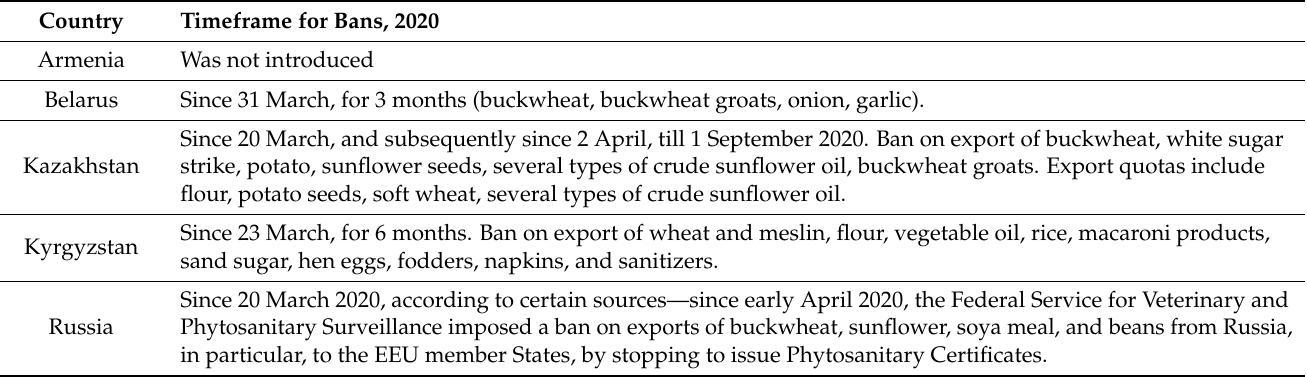
Table 3. The timeframe for the introduction of bans on the export of food, in particular, to the EEU member